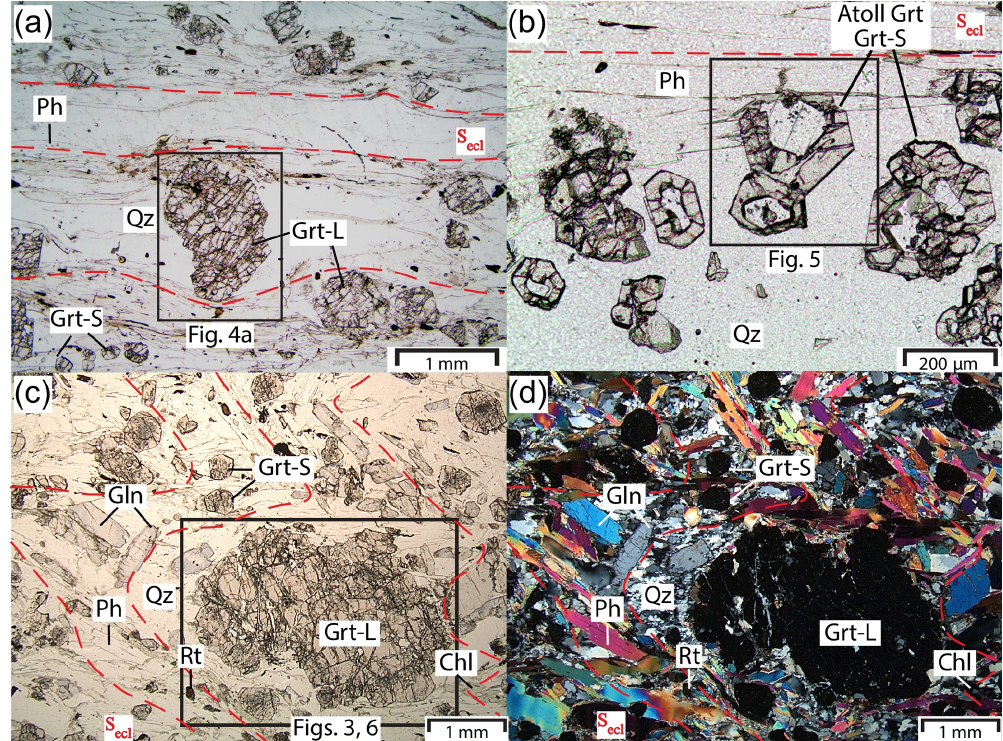
Figure 2. Thin-section optical microphotos displaying the eclogitic foliation ( S ecl , red dashed line) and the bimodal size range of garnet (large garnet grains Grt-L; small garnet grains Grt-S; see text for further details). Black squares indicate the location of the high-resolution X-ray maps presented in the following figures. (a) S ecl wrapping Grt-L grains in sample FG1315. (b) Same thin section as (a) with atoll garnets (Grt-S) located within a Qz-rich band and a Ph-rich band. (c, d) Folded S ecl marked by Ph, Gln, and Rt. Chl is present in the fold hinges. Plane-polarized light (a–c) ; cross-polarized light (d) . Table 1. Mica schists analysed (all from the Lys Valley). Mineral abbreviations from Whitney and Evans (2010). Coordinates refer to European Datum 1950UTM Zone